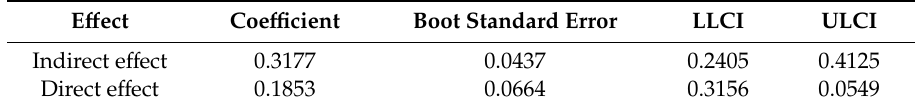
Table 5. Mediating e ff ect based on the bootstrap